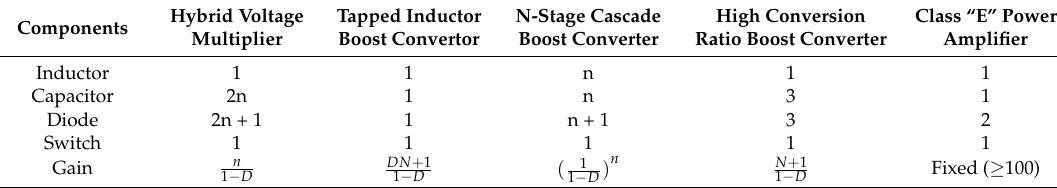
Table 3. Comparison of the main parameters of the five described